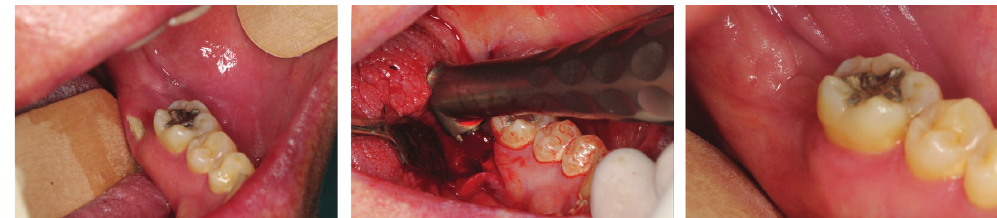
Figure 2: BRONJ on the left mylohyoid crest in a patient affected by multiple myeloma—complete healing achieved after Er:YAG surgery.